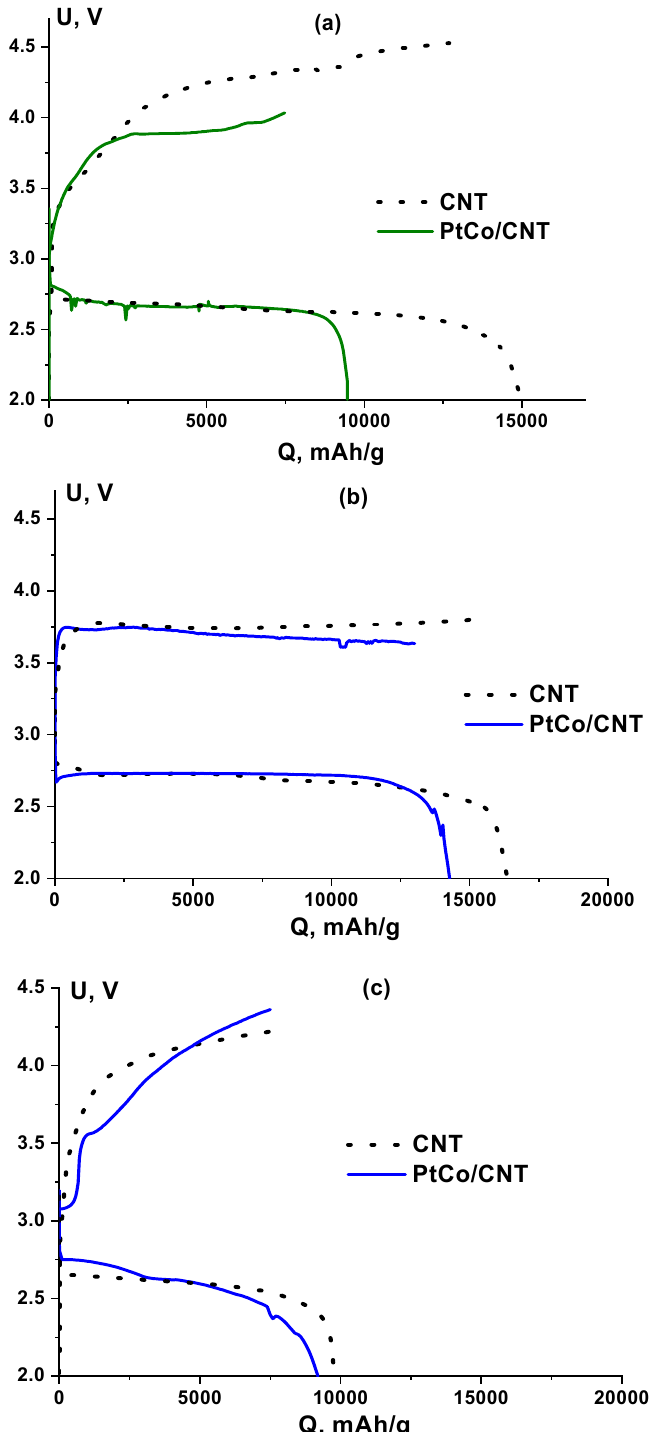
Figure 3. Discharge-charge curves of LOB obtained in an atmosphere of pure oxygen in 1M LiClO 4 /TEGDME at 200 mA/g ( a ) and in 1M LiClO 4 /DMSO at 200 mA/g ( b ) and 500 mA/g ( c ).